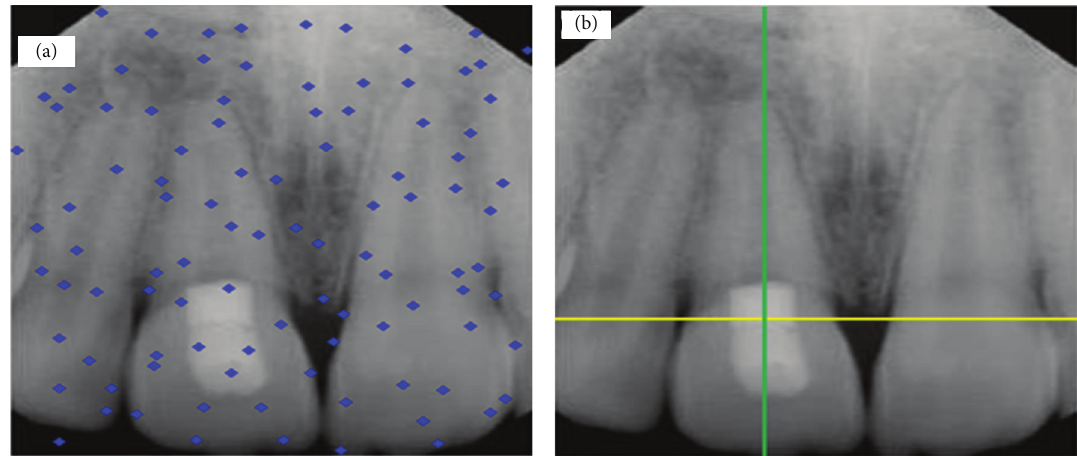
Figure 6: (a) Distribution of particles for detection of dental caries and restoration. (b) Detection of one tooth with decay and restoration, depicted by green line crossed with yellow